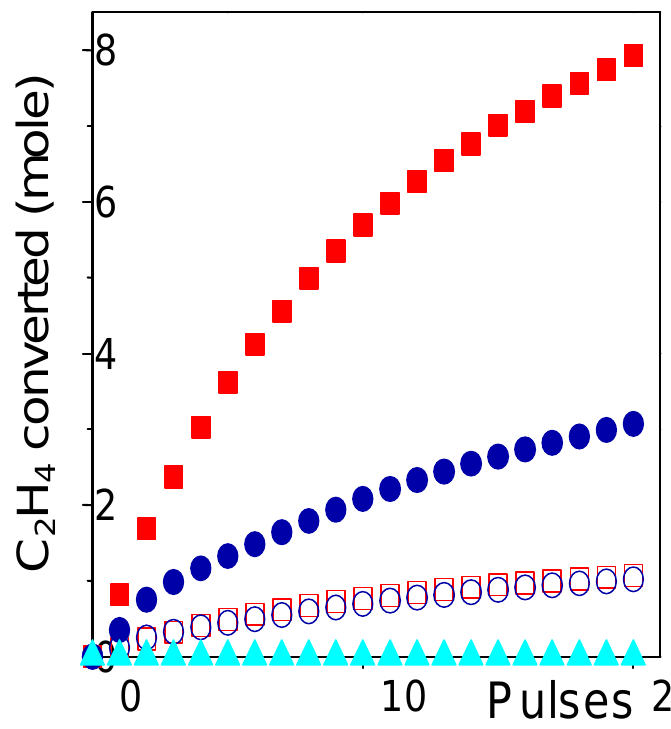
Figure 4. Ethylene conversion to 1,2-dichloroethane versus the number of pulses on 9.0, 4.6 and 1.4 wt% samples: ( g , n and s symbols respectively). Open symbols (cid:240) P and O refers to 9.0 and 4.6 wt% loaded samples normalized by “active” Cu concentration, see